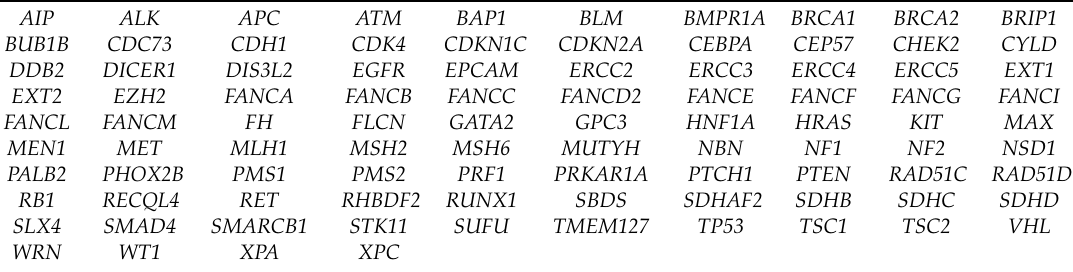
Table 1. The 94 cancer predisposition genes included in the Trusight cancer